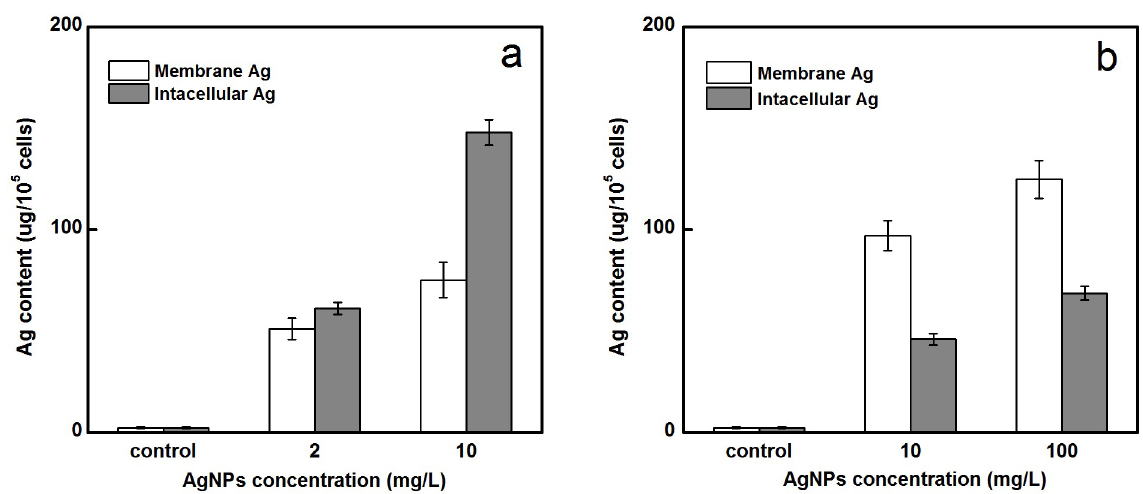
Fig 7. Intracellular and membrane Ag contents of control cells and cells treated with two size of AgNPs for 12h. (a) nano-Ag 10 and (b) nano-Ag 50.